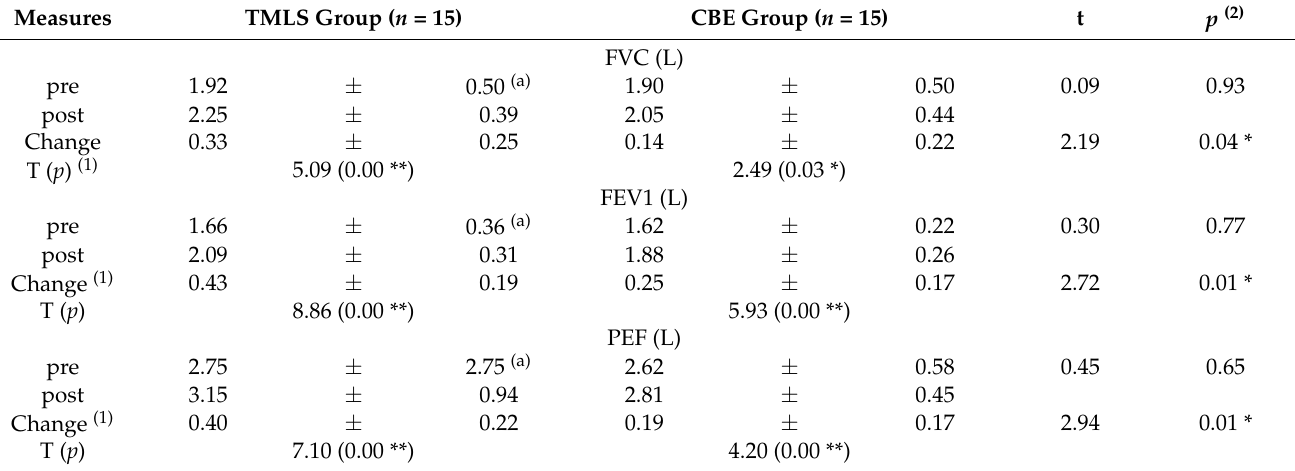
Table 3. A comparison of the respiratory function between pre-post ( n =